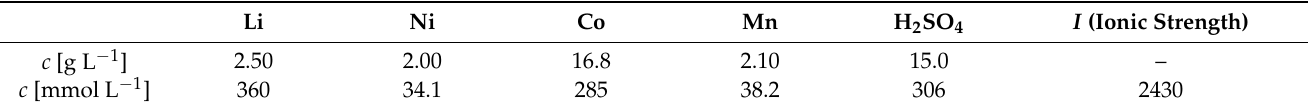
Table 1. Composition of the simulated LIB leachate. Metal concentrations adopted from [26]. Li Ni Co